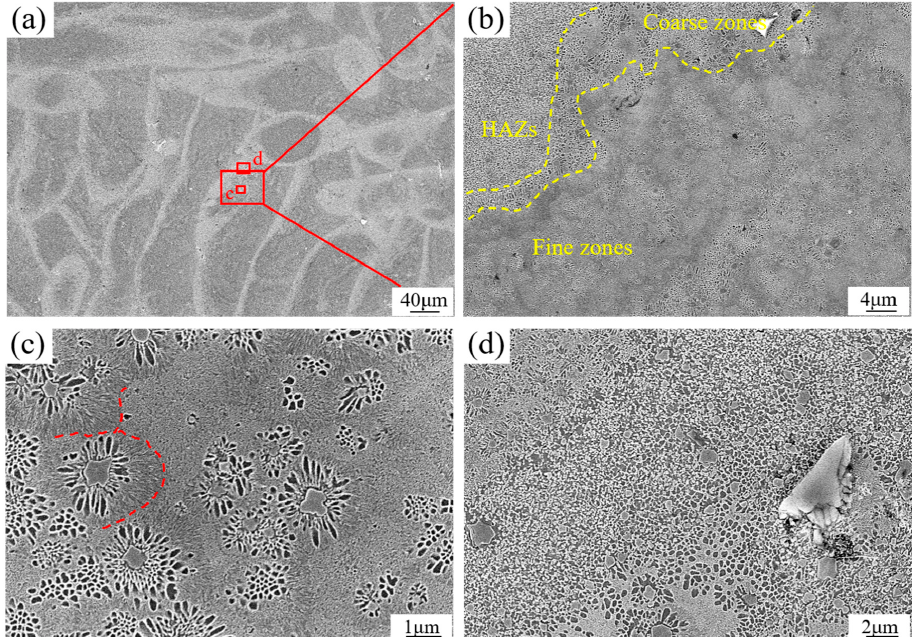
Figure 6. The microstructure of the as-built Al-Si samples in top view. The molten pool morphology of the top surface of a sample etched with Keller’s are visible in the SEM image ( a ). The structure in the red frame in the picture ( a ) is magnified to ensure visibility in the picture ( b – d ). In picture ( b ), fine zones and coarse zones are distinguished by yellow dash lines as well as the heat-affected zones (HAZs). The morphologies of fine zones and HAZs are illustrated at higher magnifications in the picture ( c , d ).